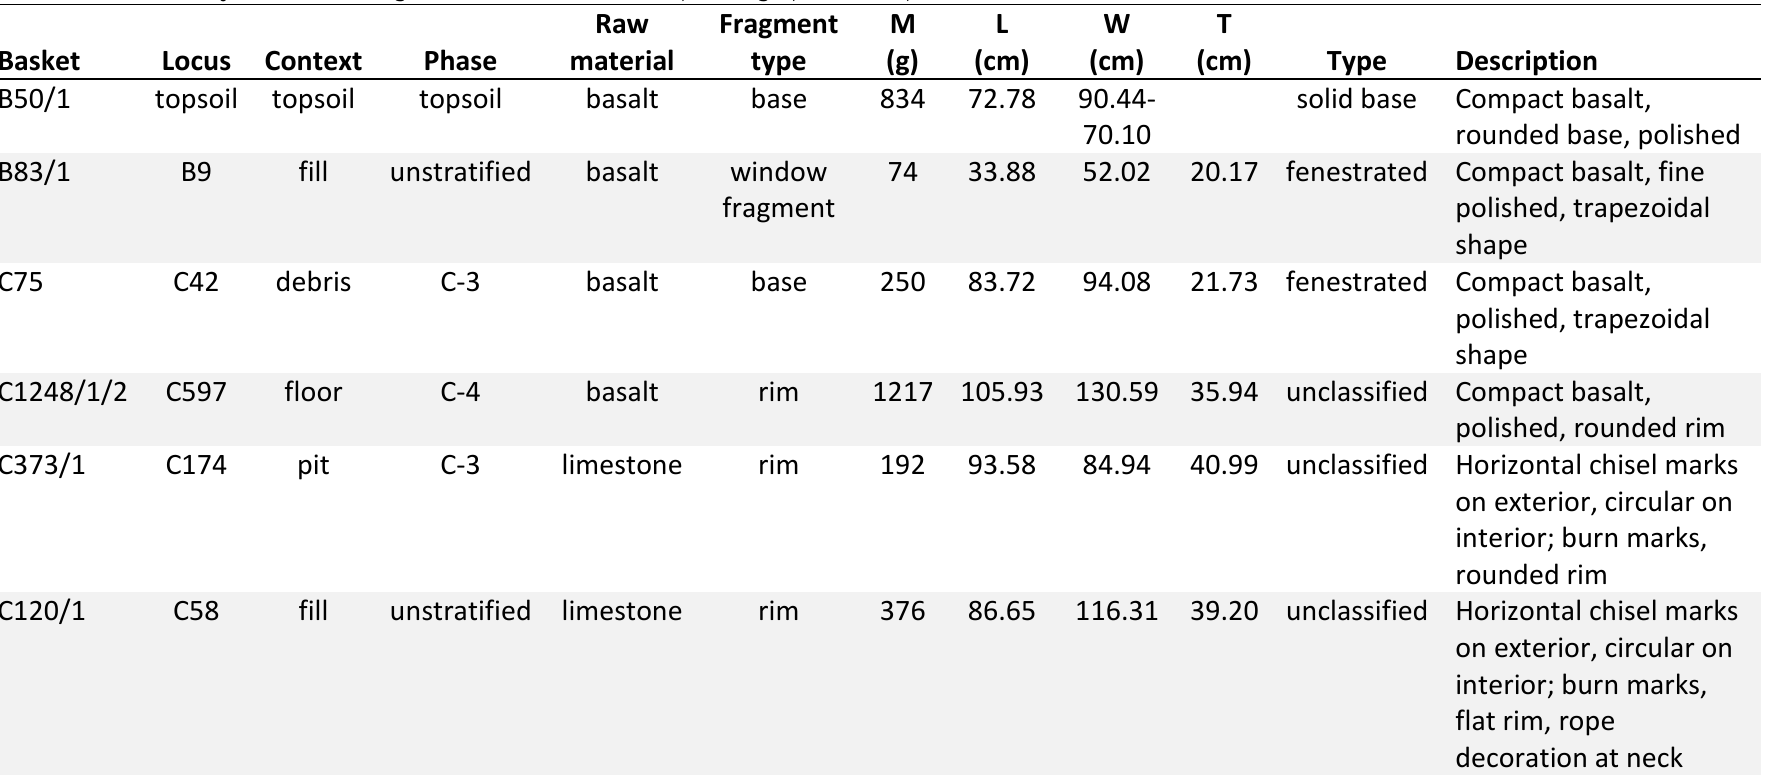
Table 2: Data summary of the assemblage. Abbreviations: M - mass, L - length, W - width, T -